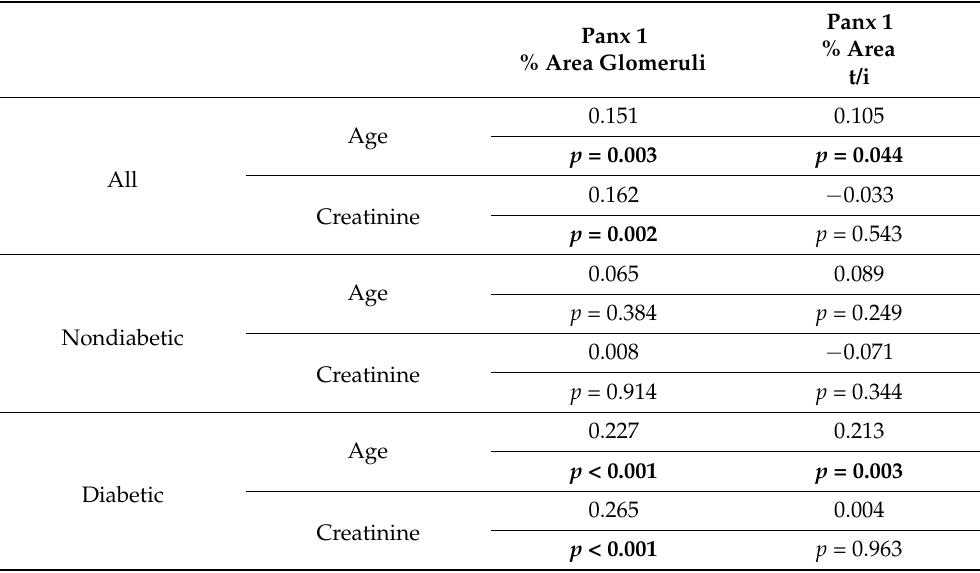
Table 3. Spearman’s coefficient of correlation of Panx1 expression in glomeruli and tubules with patient age and serum